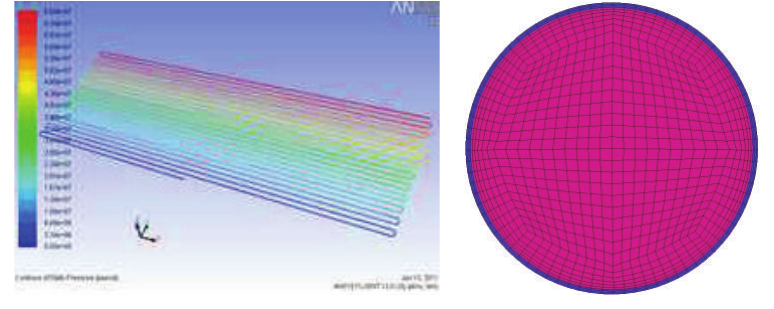
Figure 2: Modeling for single phase fluid approach.